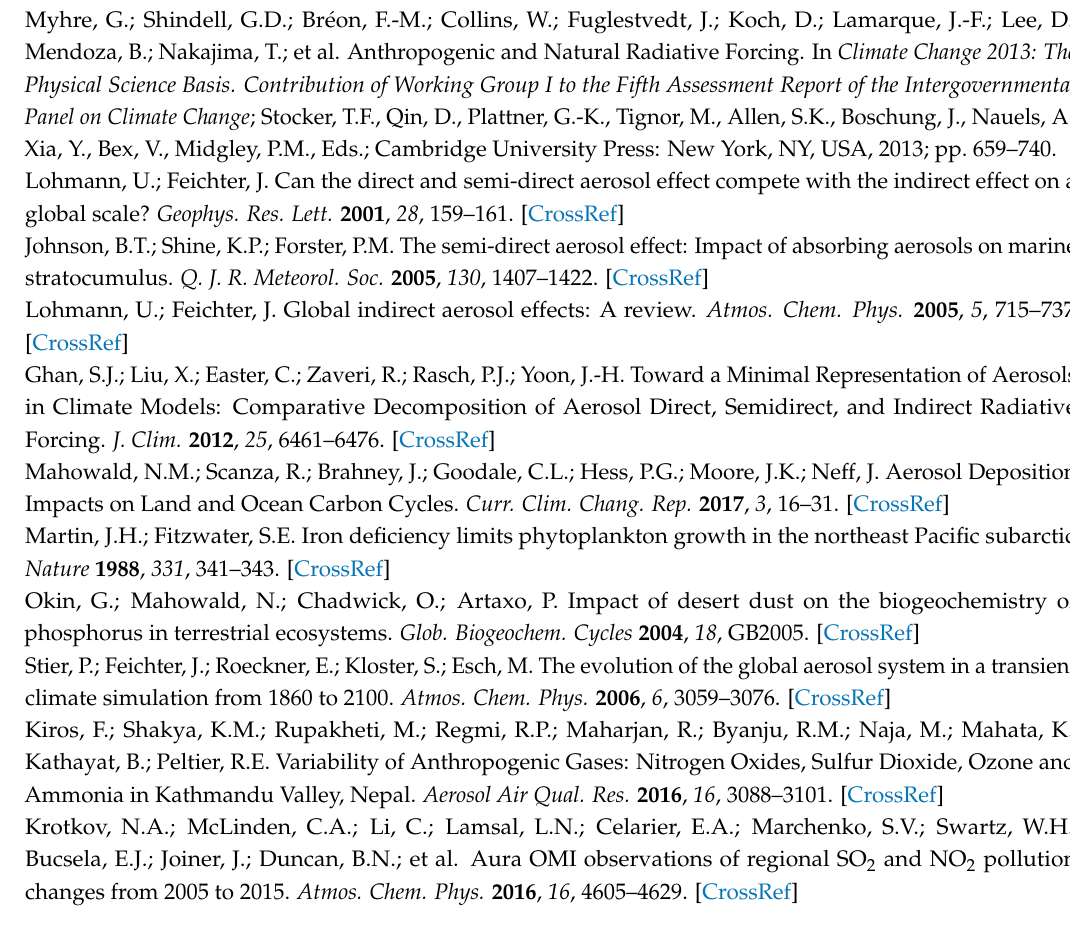
Figure S1: Loop of standardised anomalies of PBL SO 2 concentrations in DJF. Significant values are cross-hatched; the number of them is shown in parenthesis. The level of significance was set to